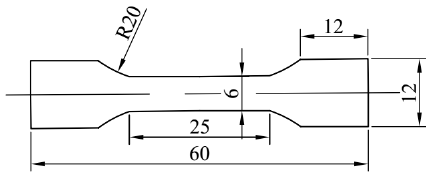
Figure 2. Shape and dimensions of the specimens for tensile tests (mm).